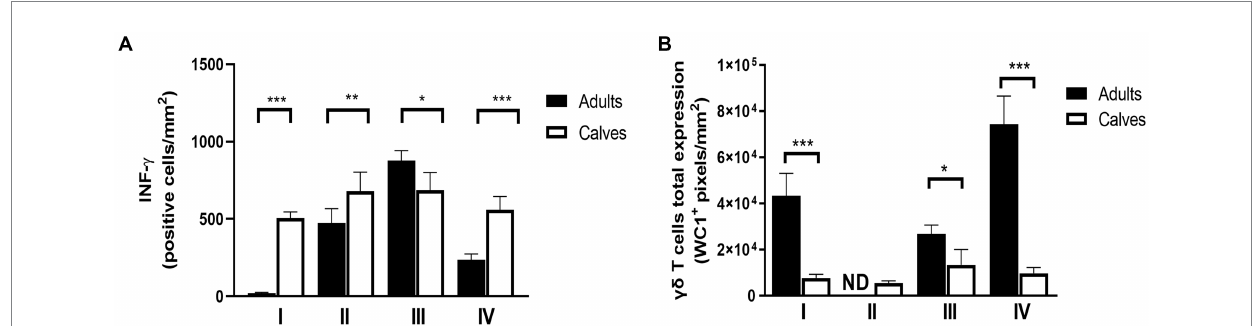
FIGURE 5 INF- γ and gamma delta T cells form granulomas have stage dependent concentration. (A) Average expression of immunolabeling for IFN- γ and (B) WC1 ( γδ T cells), respectively, in granuloma stages from adult cattle and calves. Mann–Whitney test * p < 0.05, ** p < 0.01, and *** p < 0.001. ND, not determined (because of lack to adult granulomas stage